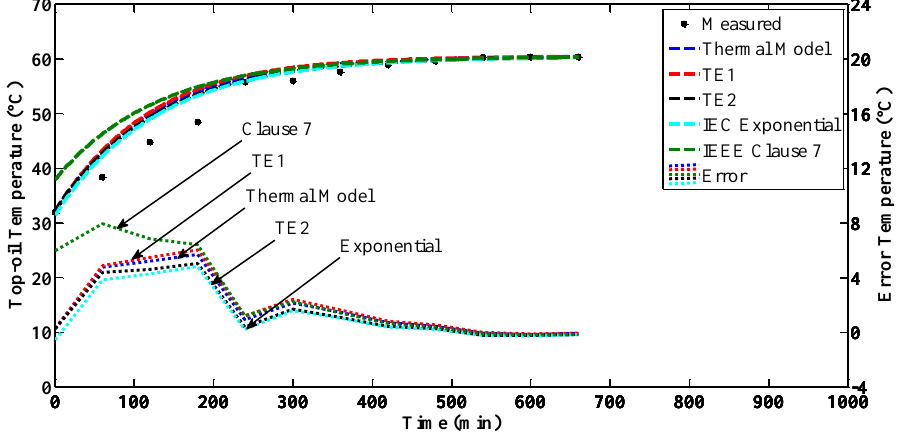
Figure 7. TOT based on different thermal models for TX1.